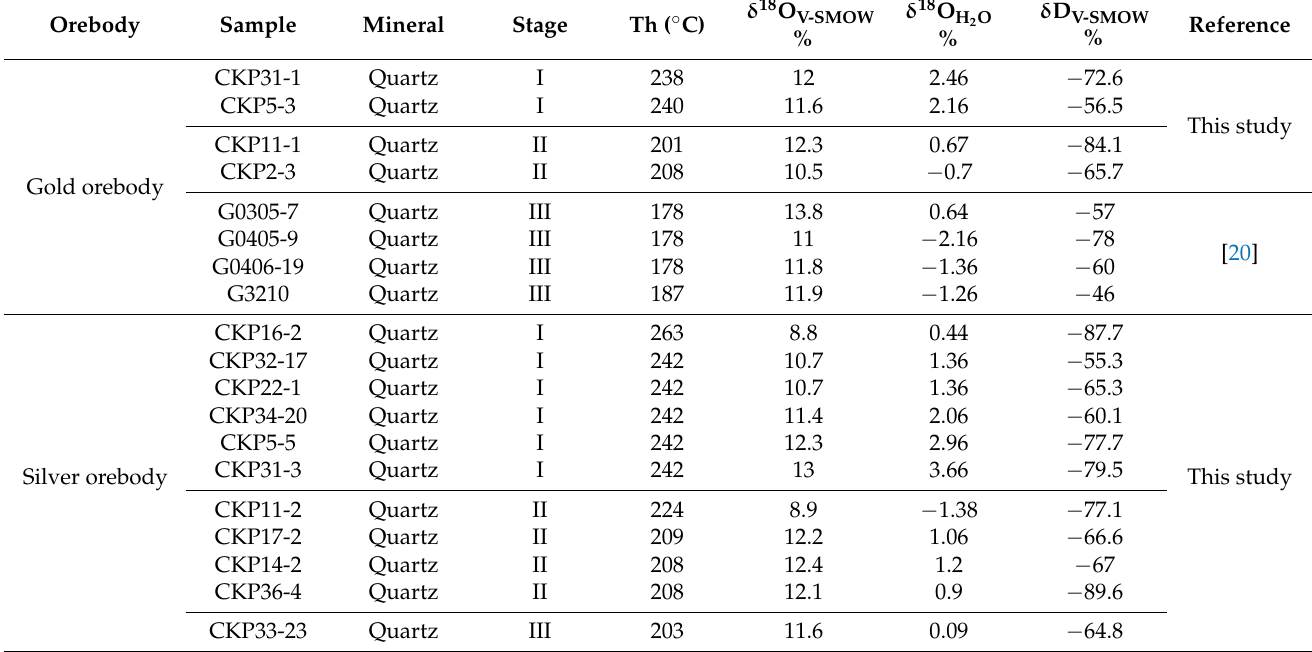
Table 2. H and O isotope data of different stages from the Changkeng–Fuwan Au-Ag deposit.